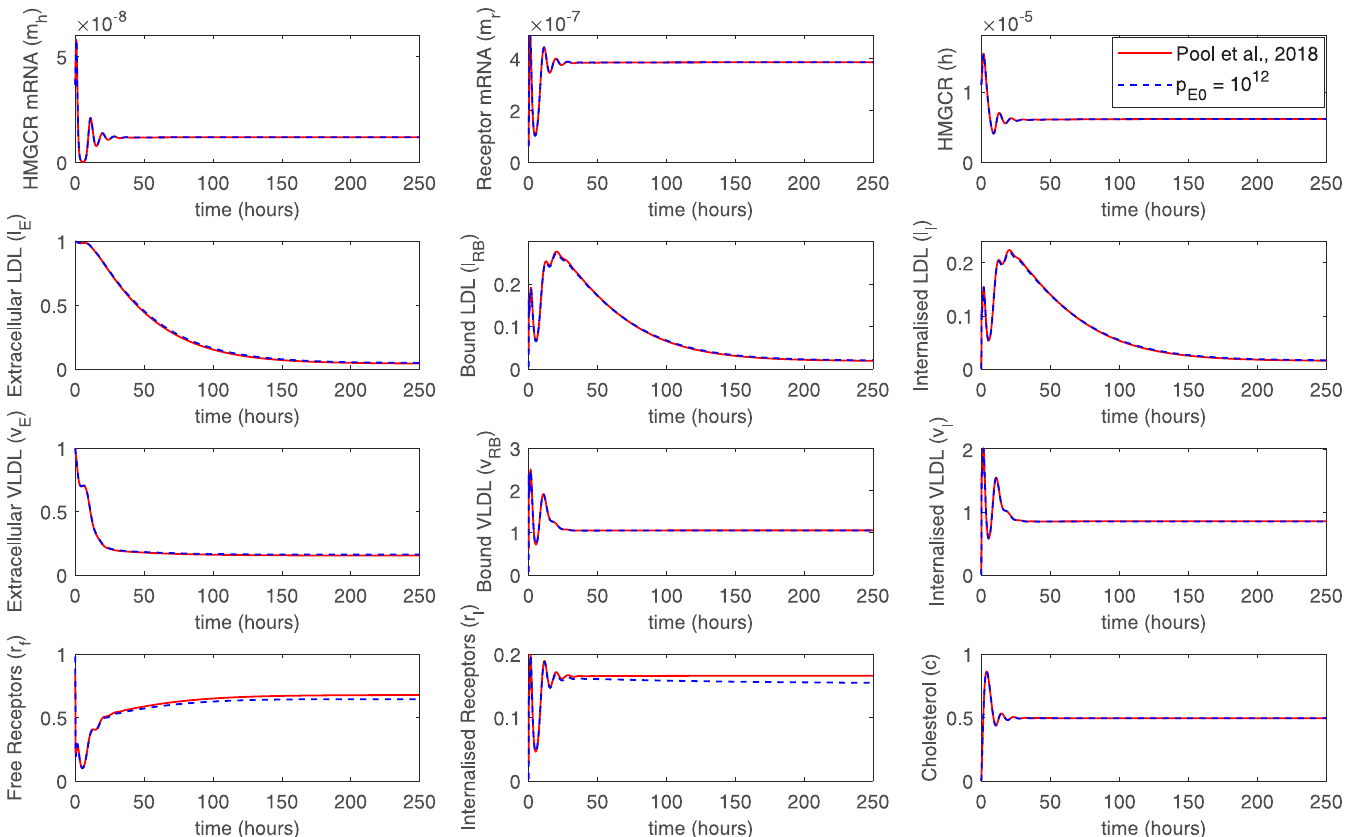
Fig 2. Comparison of numerical simulations conducted with the original model from [18] and with the newly developed model including PCSK9. In the latter, the concentration of PCSK9 in the extracellular space was 10 12 molec./mL. The initial oscillations in mRNA and molecular levels, as well as the steady-state levels are reproduced well. The slow kinetics of VLDL and LDL extraction from the extracellular environment are also captured.